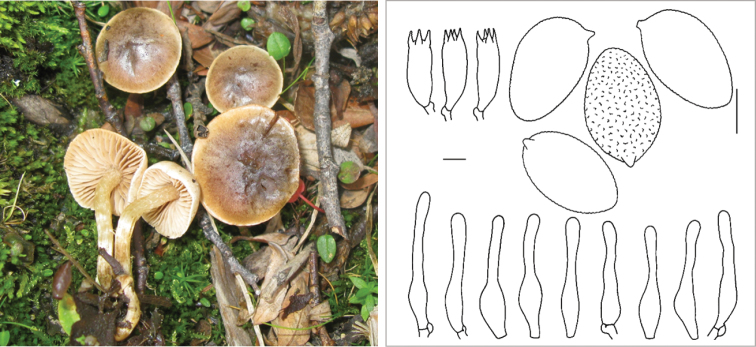
Hebelomaspetsbergense, DBG-F-027678 and BR5020184126599 (HJB 11982, from Svalbard). Scale bar for basidia and cheilocystidia 5 µm, for spores 10 µm. Drawing G. Walther, reproduced from Beker et al. (2016).